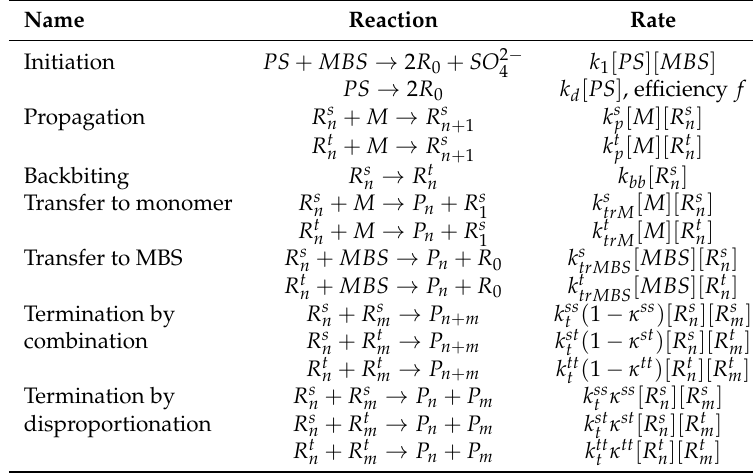
Table 2. Chemical reaction mechanism and reaction rates for the dissociated AA polymerization in water initiated by PS/MBS redox